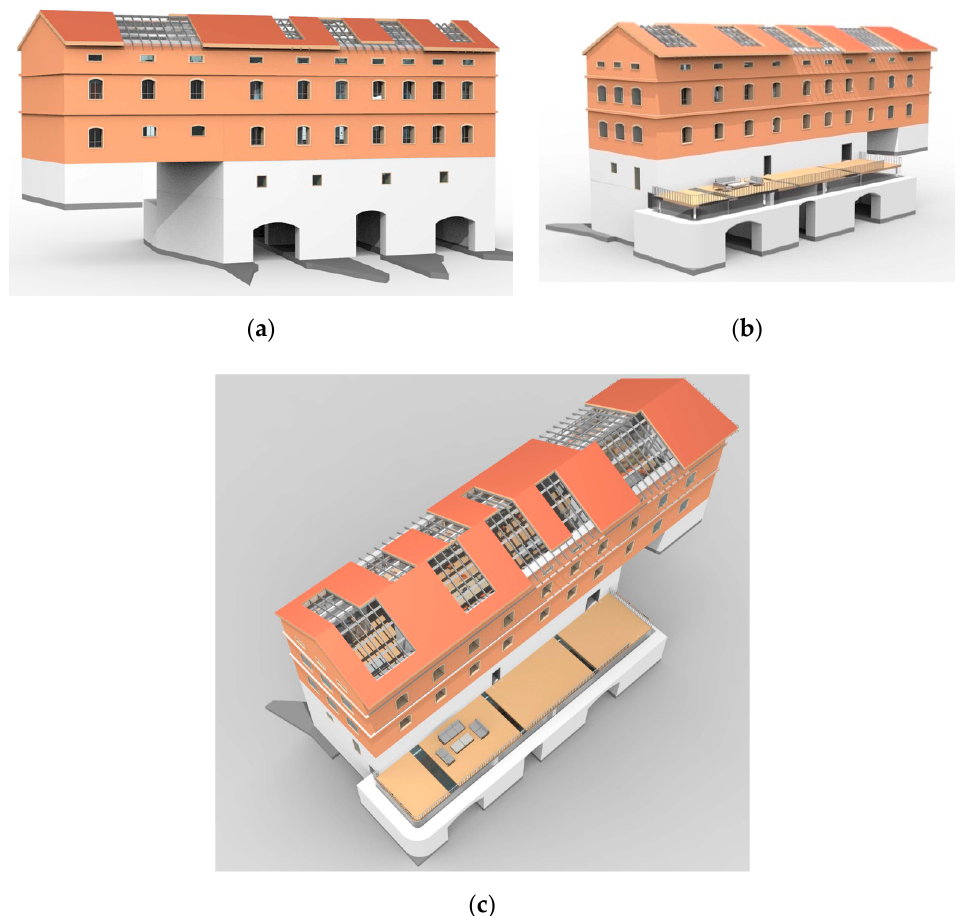
Figure 8. External renderings (BIM) of the proposed preservation. ( a ): Rear view ( b ) Front view; (c) Plant.